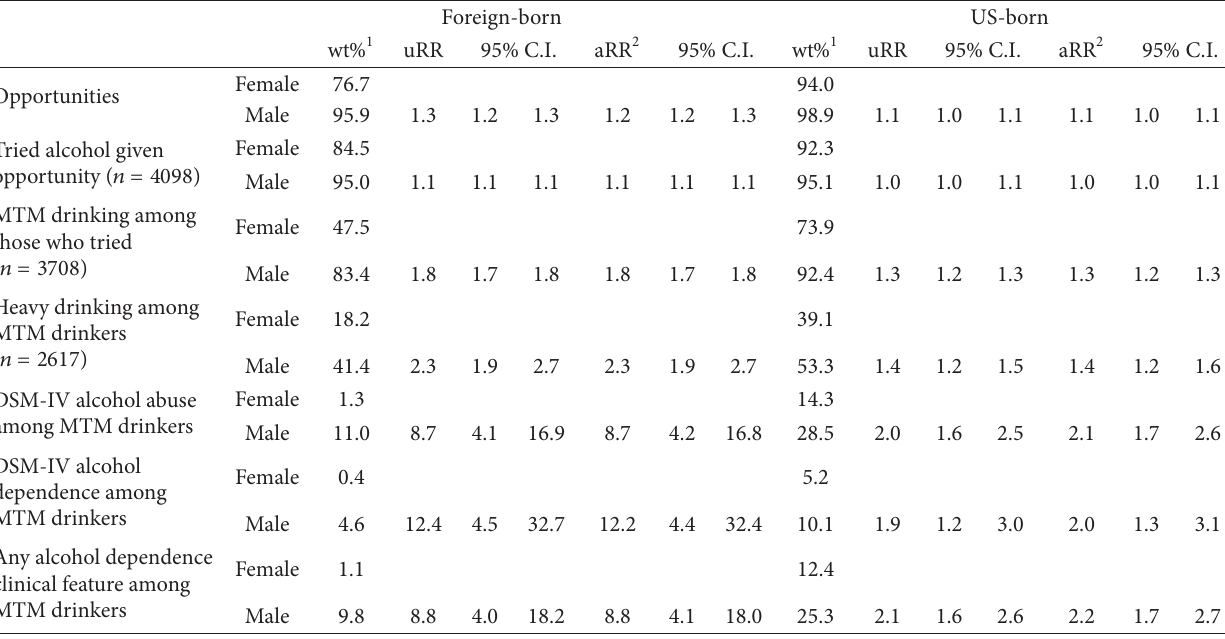
Weighted percentage. MTM: more than minimum drinking. 2 T 2: Male-female relative risks for transitions of alcohol drinking and AUD strati�ed by the place of birth. Data from NLAAS,